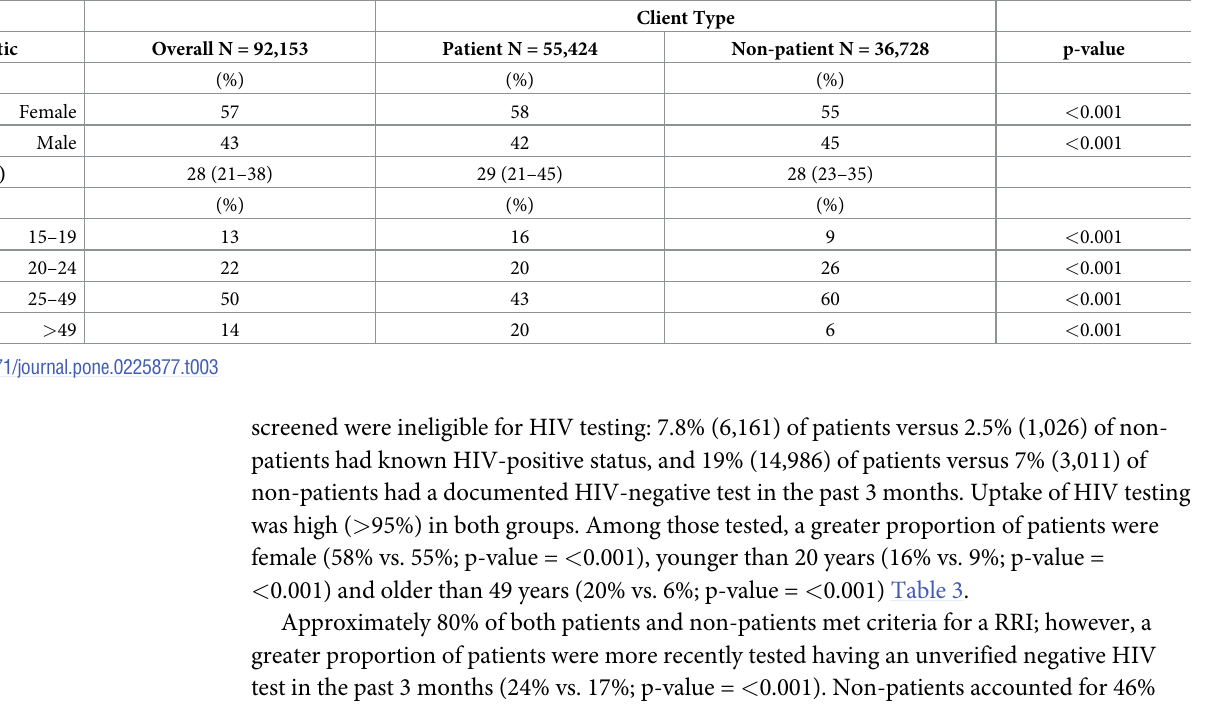
Table 3. Characteristics of patients and non-patients tested for HIV at selected facilities in Siaya, Kisumu and Homa Bay Counties, Kenya. Characteristic